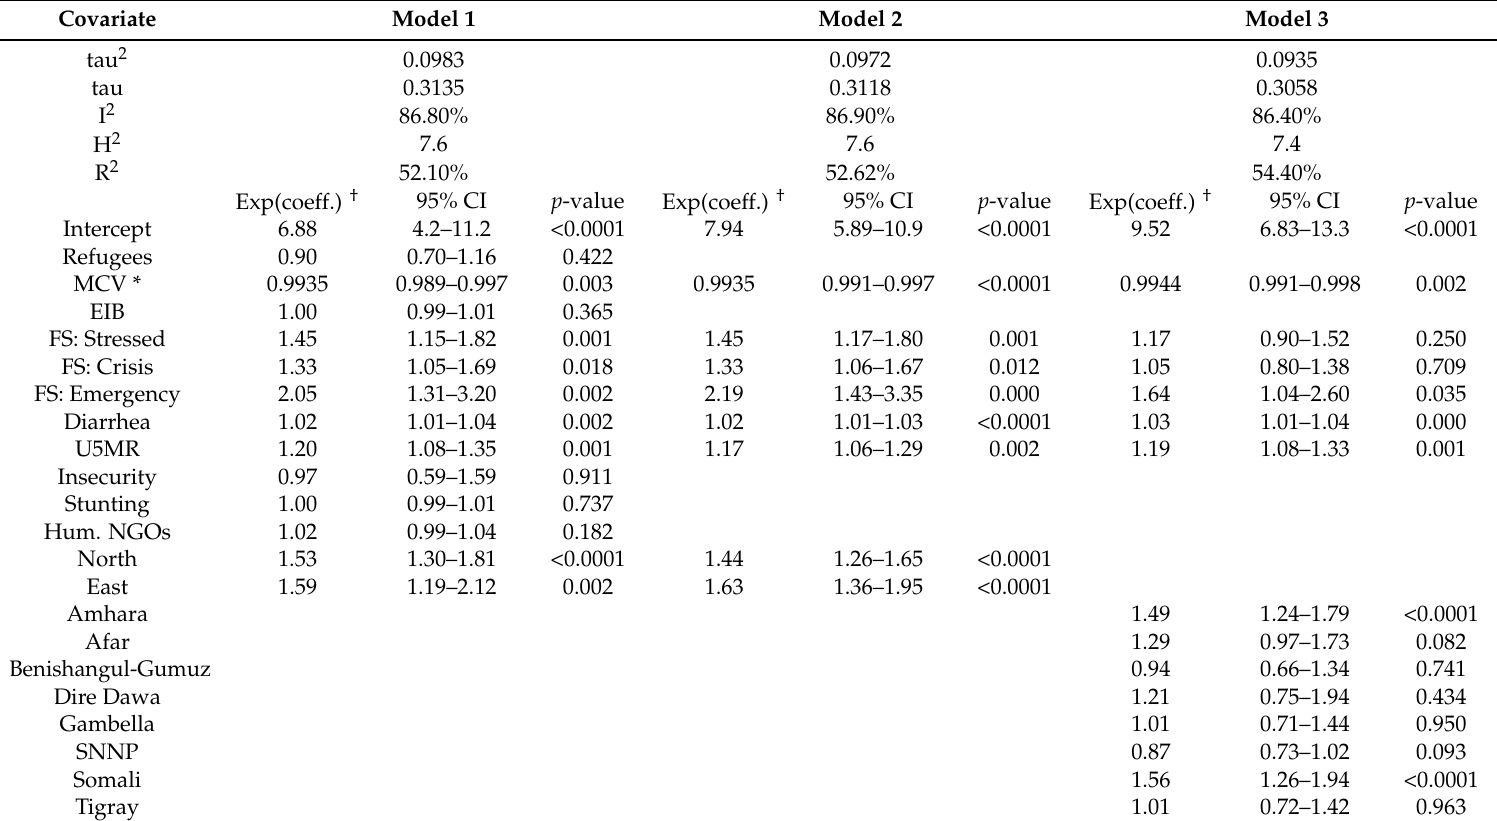
Table 4. Results of multivariate meta-regression analysis, Ethiopia emergency pockets,